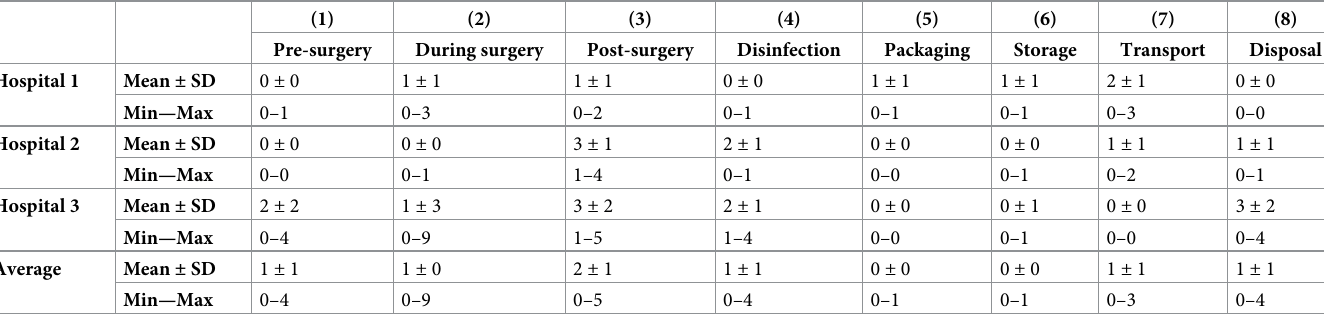
Table 2. Analysis of the airborne microbial load during use and reprocessing using settle plates.